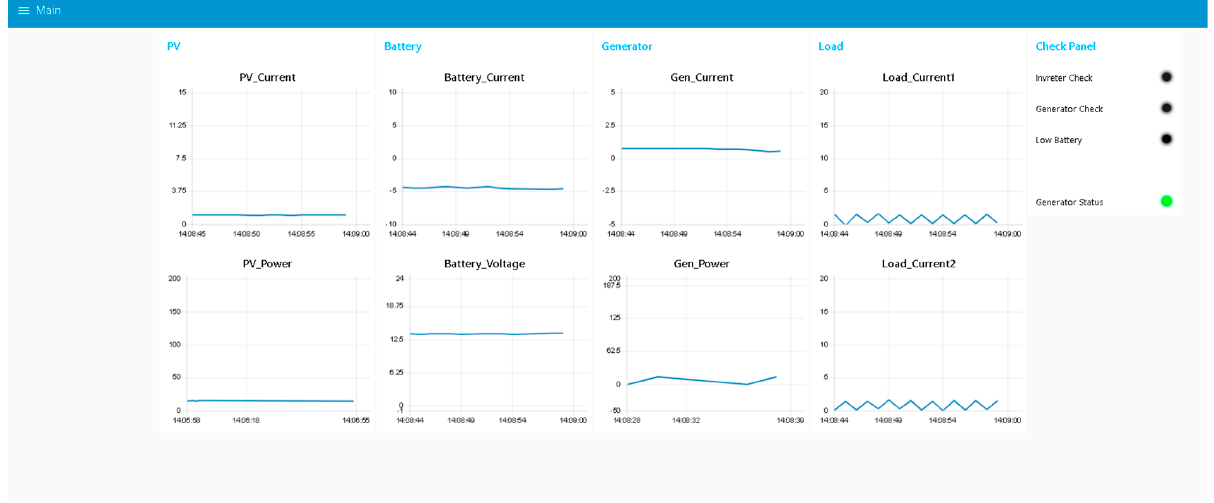
Figure 13. Node - Red dashboard for visualization.